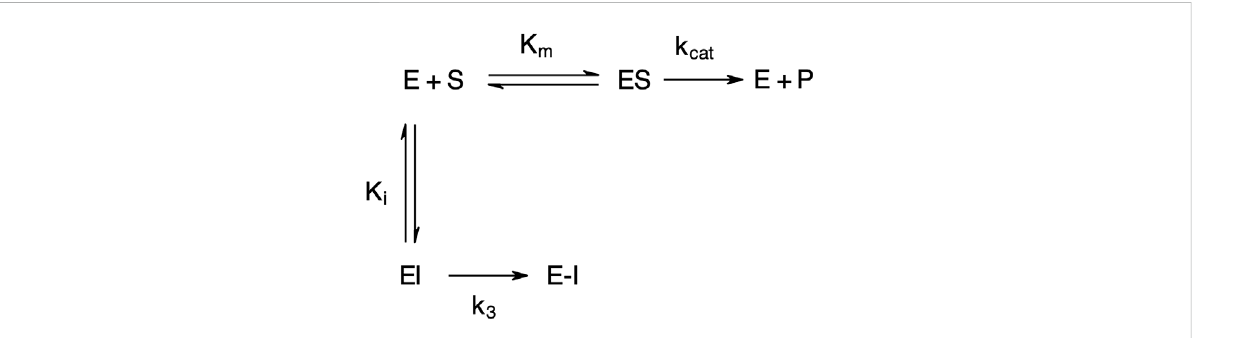
FIGURE 6 Scheme for irreversible inhibition. E, Enzyme; S, Substrate; ES, Enzyme-Substrate complex; P, Product; EI, Enzyme-Inhibitor complex; Km, Michaelis-Menten constant; K